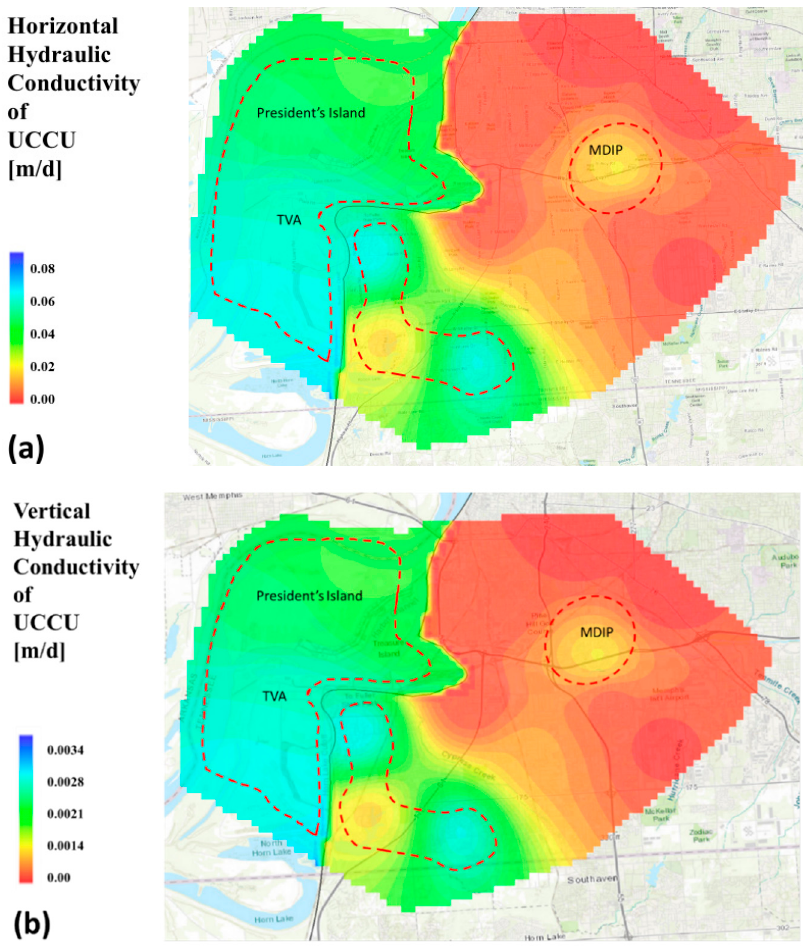
Figure 7. ( a , b ) show observed vs simulated results of the model for the Shallow and Memphis aquifers, respectively.